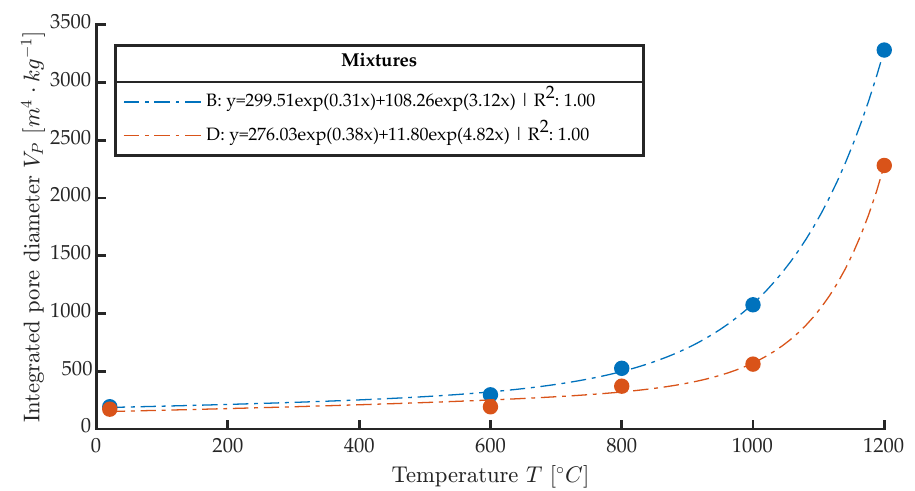
Figure 12. Integrated pore size of mixtures B and D from mercury porosimetry